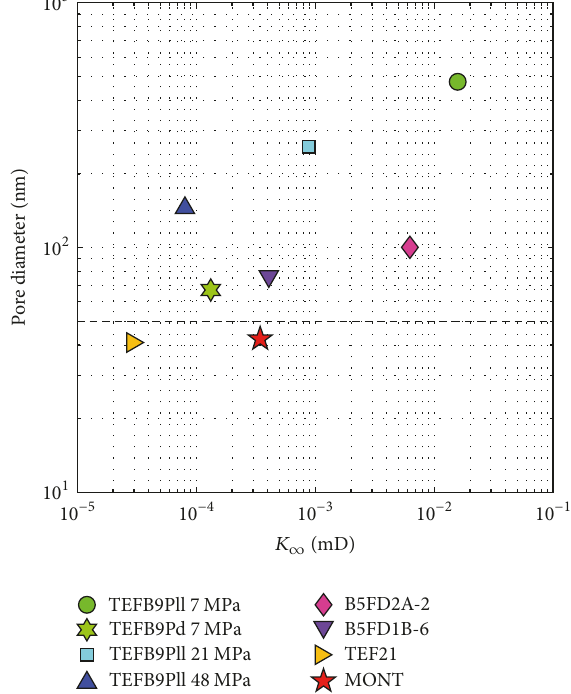
Figure 6: Dominant pore size calculated using (2) and the helium Klinkenberg plot data. Pores are generally smaller in samples with lower 𝐾 ∞ , but with lots of variability around the trend. Dashed line delineates the macropore-mesopore boundary below which capillary condensation is expected at ethane gas pore pressures close to the saturated vapour pressure